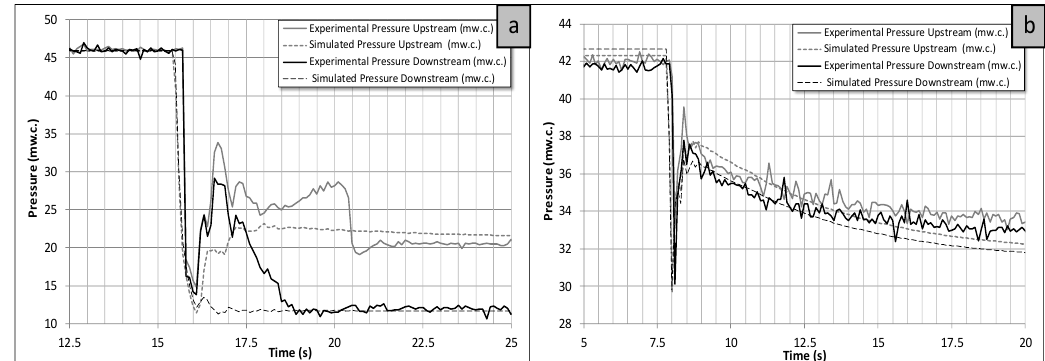
Figure 12. Experimental data and simulation for pressure variation due to a fast opening downstream control valve of ( a ) radial and ( b ) axial machine.